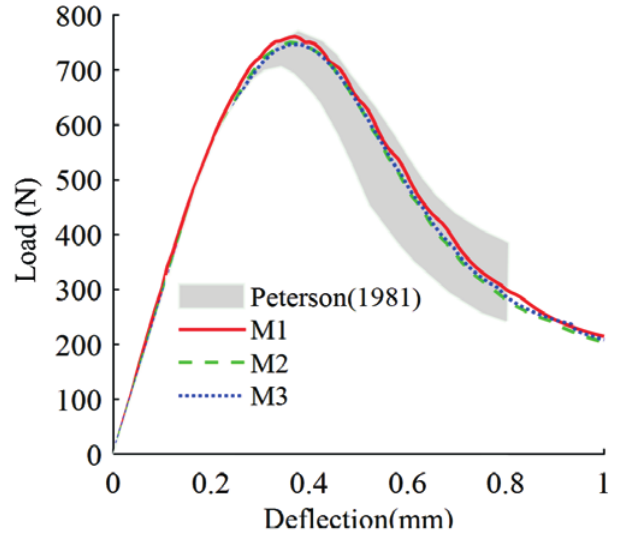
Figure 11 Load x Deflection of the beam with linear and exponential softening